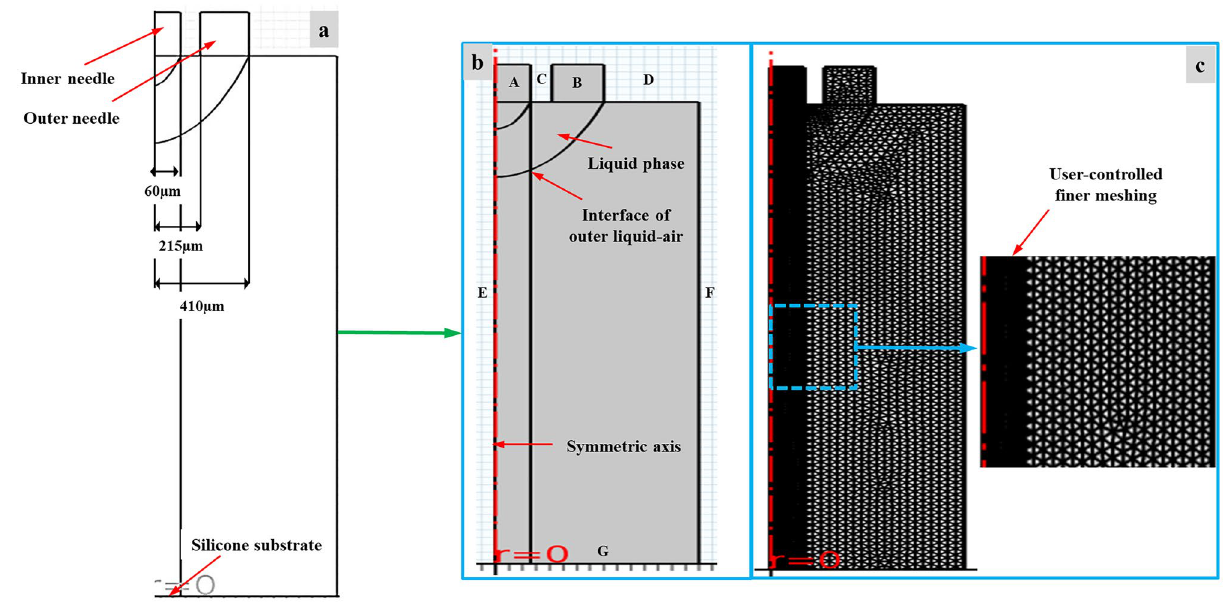
Figure 4. ( a ) The design of 2D sketch ( b ) The axisymmetric geometry of phase field model and particular boundary conditions ( c ) the finer user-controlled meshing for